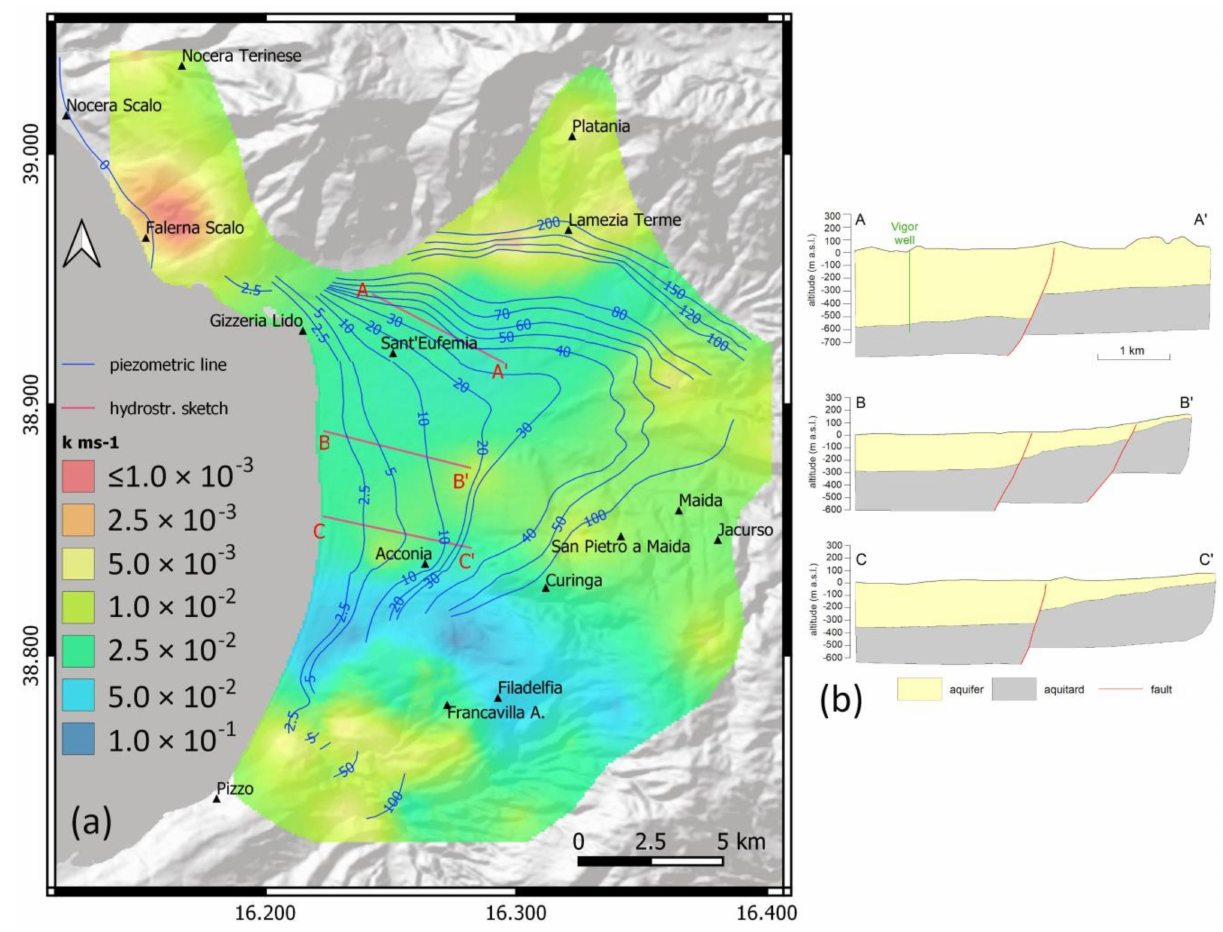
Figure 2. ( a ) Distribution map of hydraulic conductivity (k) of the aquifer and piezometric lines. ( b ) Hydrostratigraphic sketches showing aquifer and